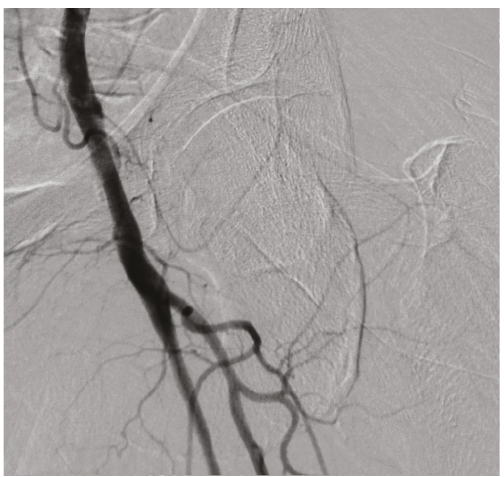
Figure 6: Final left femoral angiogram con fi rming hemostasis and absence of femoral artery abnormality or complication.